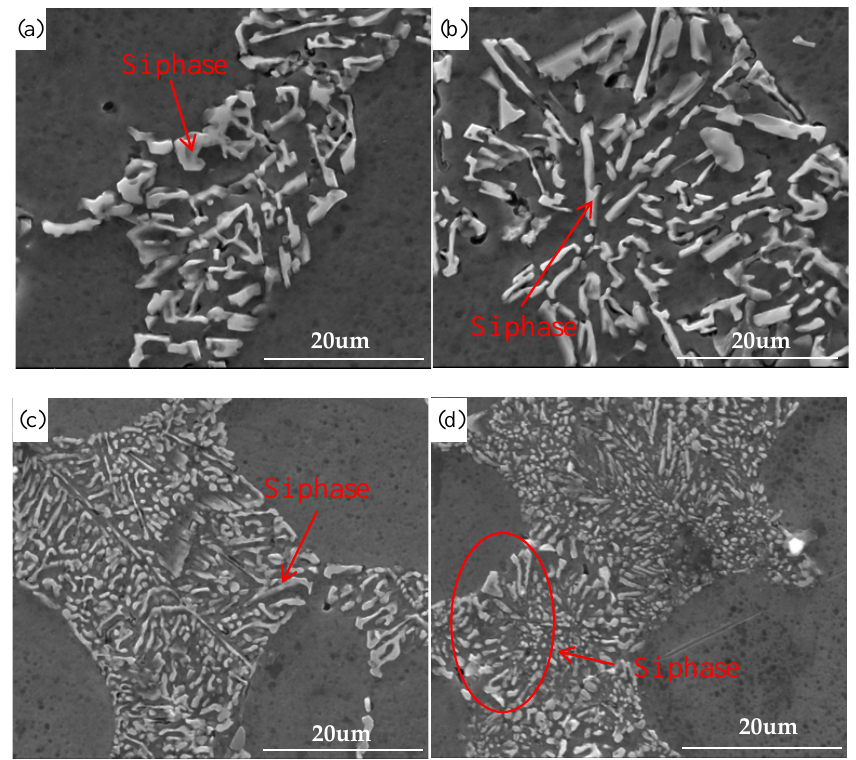
Figure 8. SEM images of eutectic phase of vacuum counter-pressure casting aluminum alloy under different ultrasonic temperature; ( a ) 680 °C, ( b ) 700 °C, ( c ) 720 °C, ( d ) 740 °C.